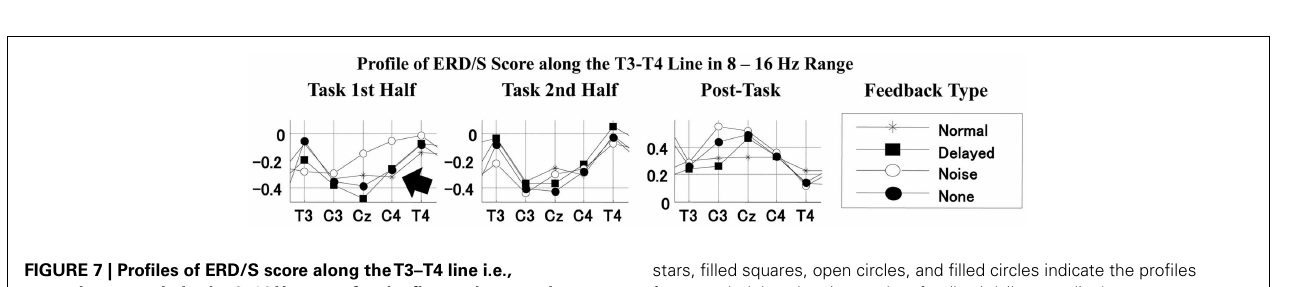
FIGURE 7 | Profiles of ERD/S score along theT3–T4 line i.e., sensorimotor strip in the 8–16Hz range for the first task, second task, and post-task intervals for each feedback type. Lines with